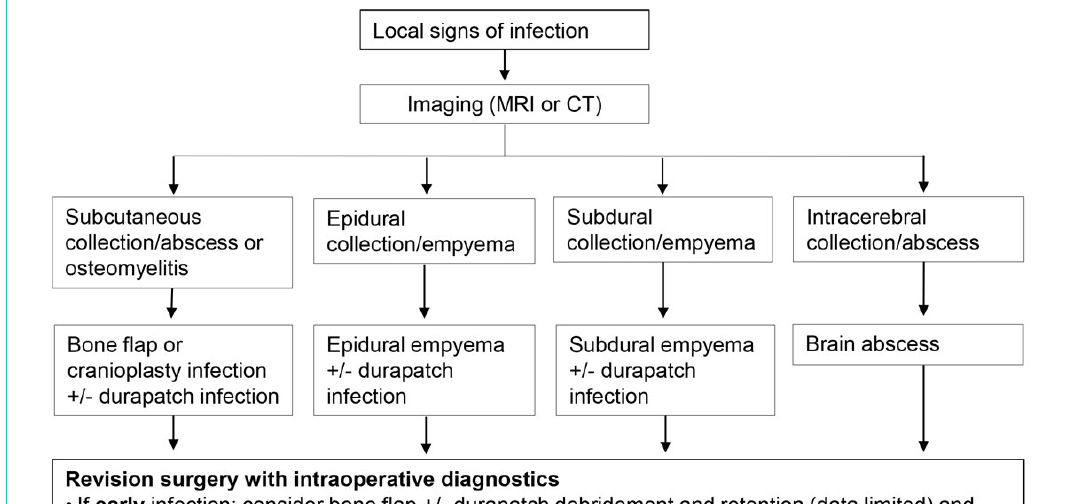
Figure 2: Management algorithm for craniotomy- and cranioplasty-associated infections. Antibiotics with biofilm activity: rifampin for staphylococci and Cutibacterium spp.; fluoroquinolones for gram-negative bacilli.MRI = magnet resonance imaging; CT = computed tomogra- phyBlue frame = intradural treatment; green frame = extradural